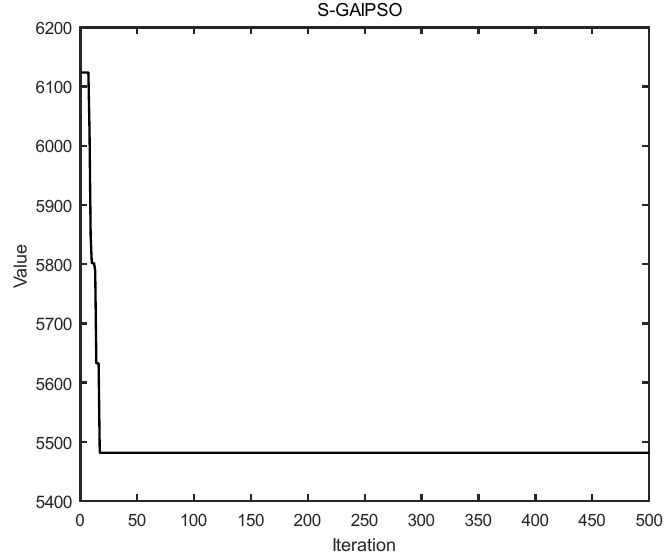
Figure 7. Schematic illustrations of the search process.